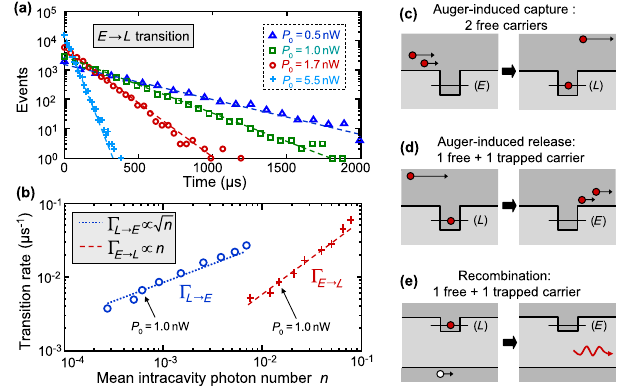
FIG. 3. (a) Histogram of the time spent in state E before returning to state L , at T ¼ 34 . 1 K and ω ¼ 1 . 32411 eV, for various excitation powers. Dashed lines: numerical fits for monoexponential decays, from which the transition rates Γ E → L are extracted. (b) Measured transition rates Γ E → L and Γ L → E , extracted from the real-time measurements, as a function of the intracavity photon number n . Two different photon numbers are considered for each value of the incident power P 0 : the photon number in the E state governs the Γ E → L transition rate, while the photon number in the L state governs the Γ L → E transition rate. Dashed and dotted lines: numerical fits (see legend). (c) – (e) Schematic view of some microscopic processes allowing for capture and release